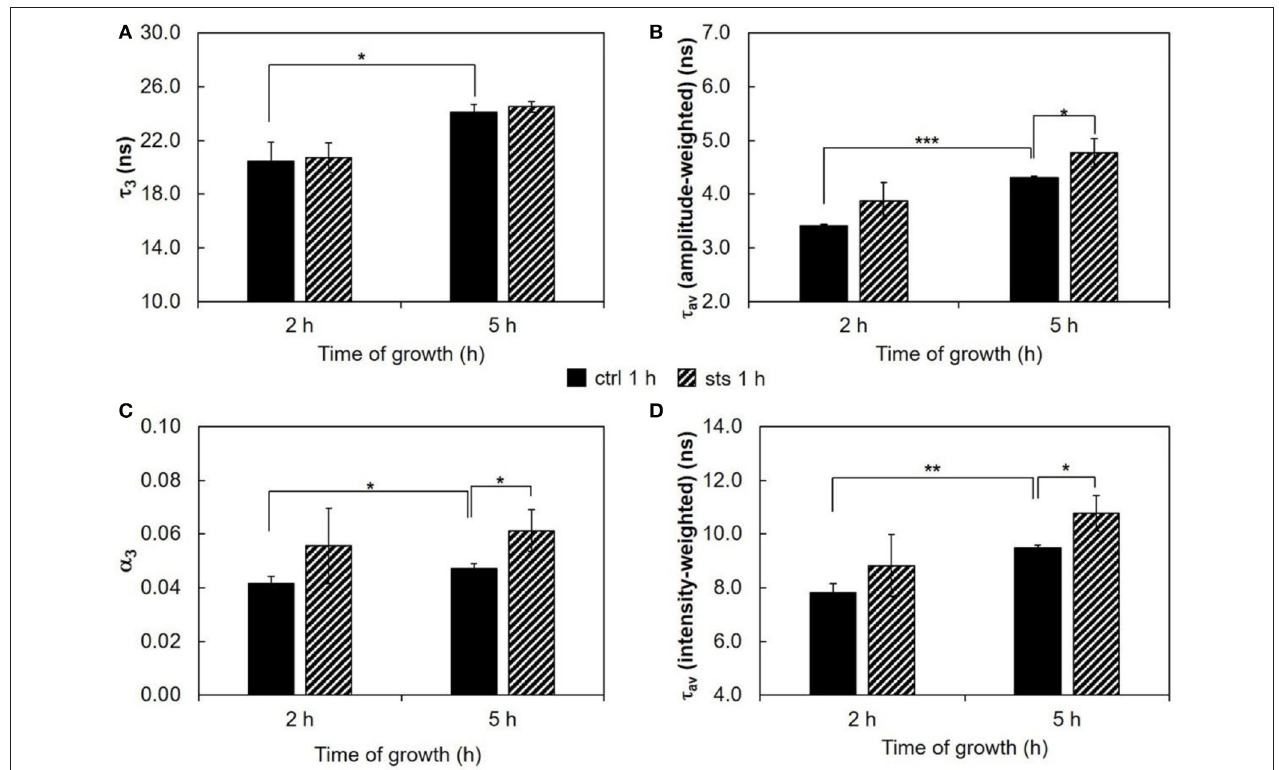
FIGURE 3 | Time-resolved fluorescence spectroscopic parameters of t- PnA in the plasma membrane of N. crassa conidia. (A) The long lifetime component, τ 3 , (B) amplitude-weighted mean fluorescence lifetime, τ av (amplitude-weighted), (C) normalized amplitude of the long component, α 3 , and (D) intensity-weighted mean fluorescence lifetime, τ av (intensity-weighted), of t -PnA were obtained from the fluorescence intensity decay of the probe at 30 ◦ C. The results present the mean ± S.D. of at least three independent experiments, n ≥ 3. * p < 0.05, ** p < 0.01, *** p < 0.001.